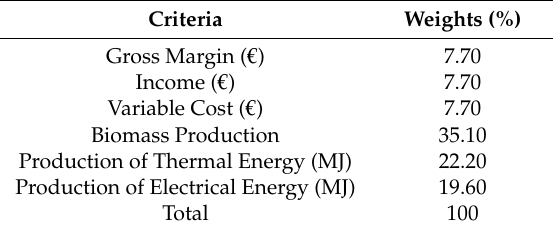
Table 4. Weights of each